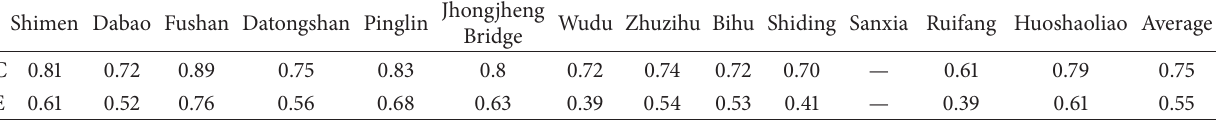
Table 6: Coefficients of correlation and efficiency during Typhoon Aere (2004) (data at Sanxia gage was